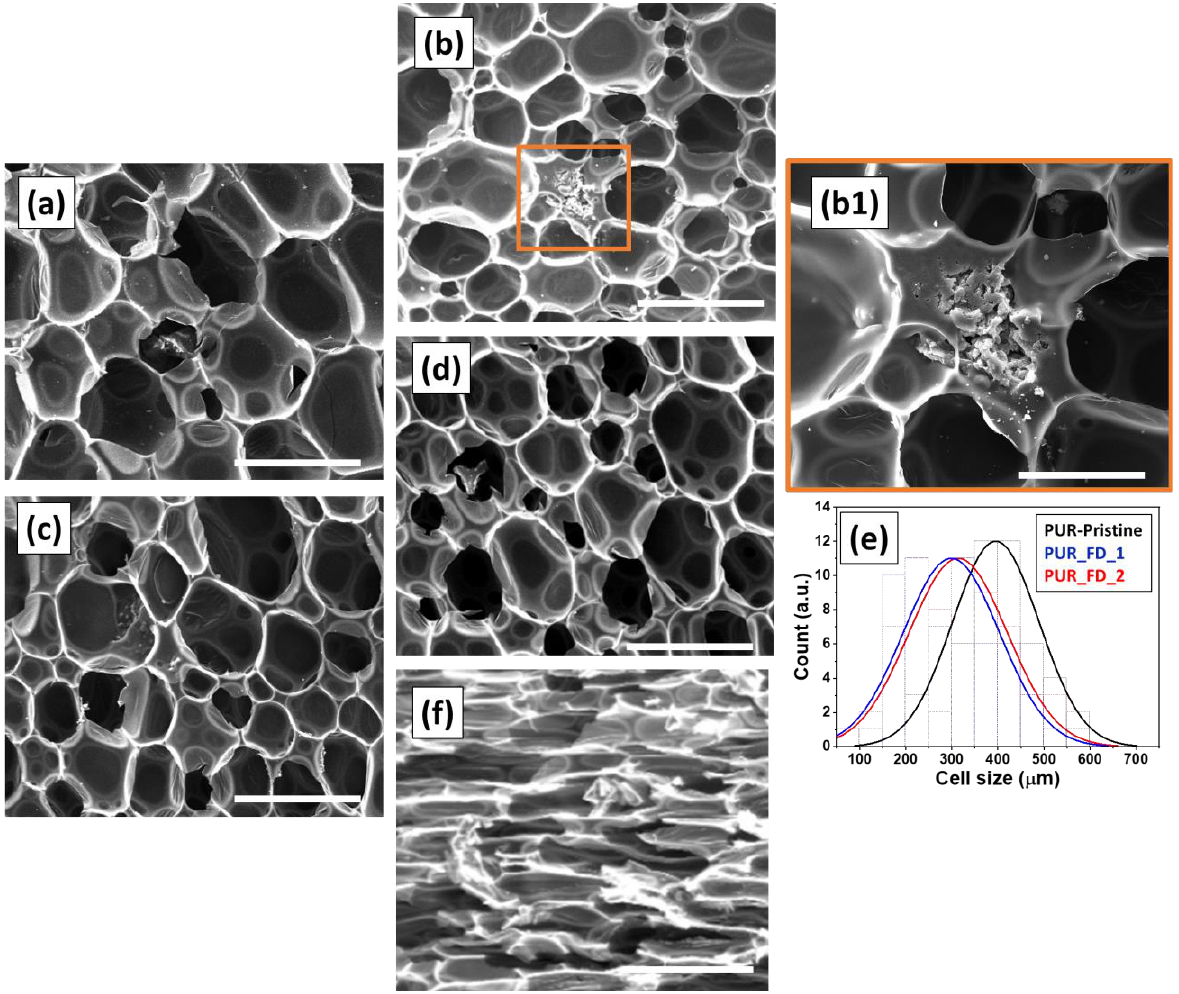
Figure 6. ( a – d ) SEM micrographs of PUR_Pristine, PUR_FD_0, PUR_FD_1, PUR_FD_2, respectively, at 200× magnification, scale bar = 500 μm; ( b1 ) 500× Magnification of PUR_FD_0, scale bar 200 μm; ( e ) Cell size distribution of selected foams; ( f ) SEM micrographs of collapsed PUR_SE_1, 200× magnification, scale bar = 500 μm.